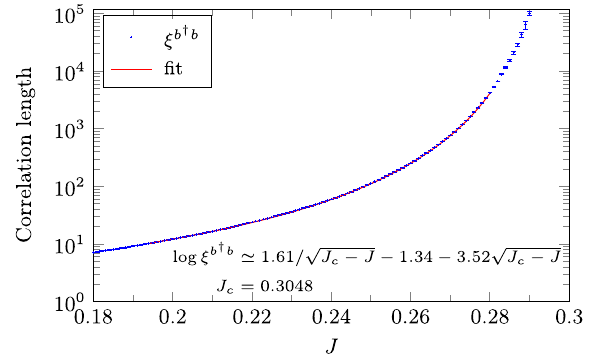
FIG. 6. One-dimensional Bose-Hubbard model with h n i ¼ 1 . We show extracted values of the correlation lengths associated with h b † 0 b correlator. By fitting the scaling form in Eq. (19), we R i find the position of the critical point and nonuniversal constant B in this model. See text for details.